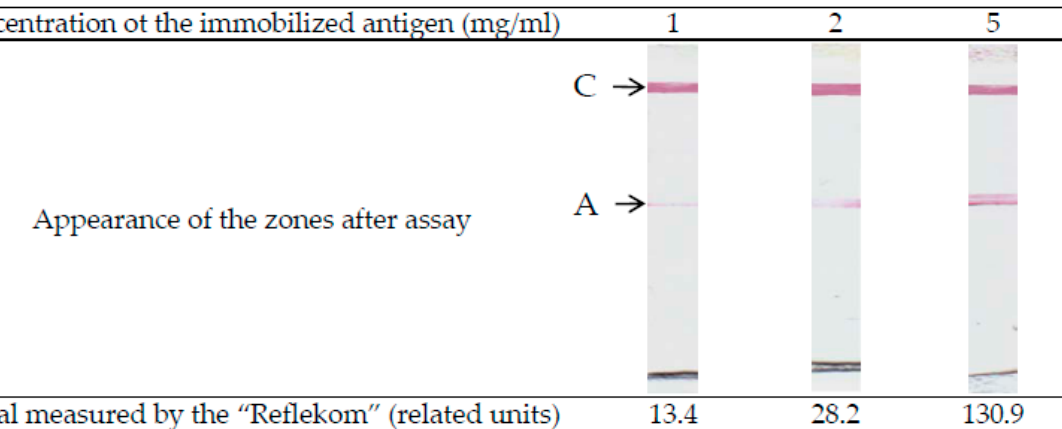
Figure 8. Influence of concentration of the immobilized antigen on the coloration of analytical zone (appearance of working membranes for antibody concentration 200 ng/mL, D520 of the antigen conjugate with gold nanoparticles—2). A—analytical zone; C—control zone.